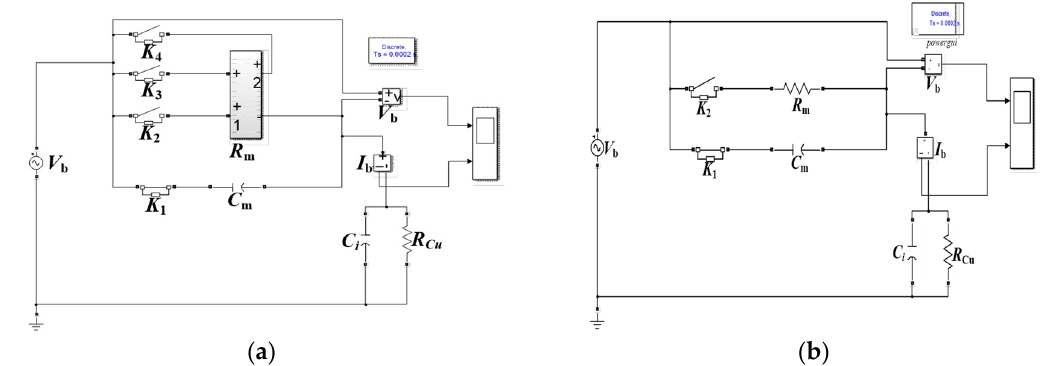
Figure 9. Simulation circuit of bearing breakdown with ( a ) the variable breakdown resistance model ( b ) the constant breakdown resistance model.